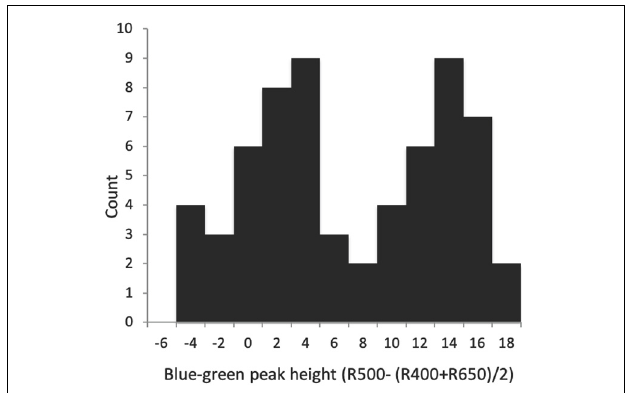
FIGURE 3 | Histogram of blue–green spectral reflectance peak height of Rüppell’s weaver eggs (63 eggs in 26 clutches), suggesting a bimodal distribution of